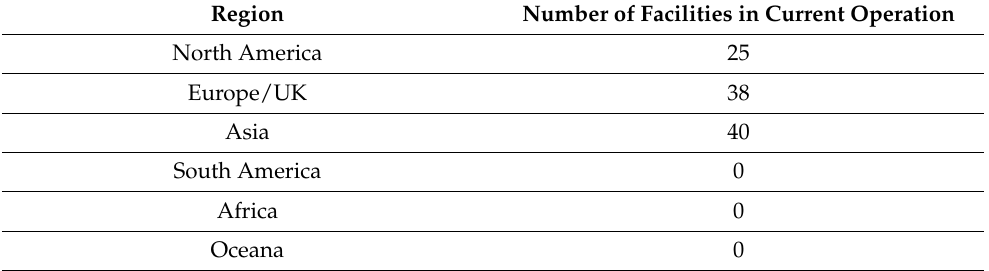
Table 1. Particle therapy facilities in clinical operation as of October